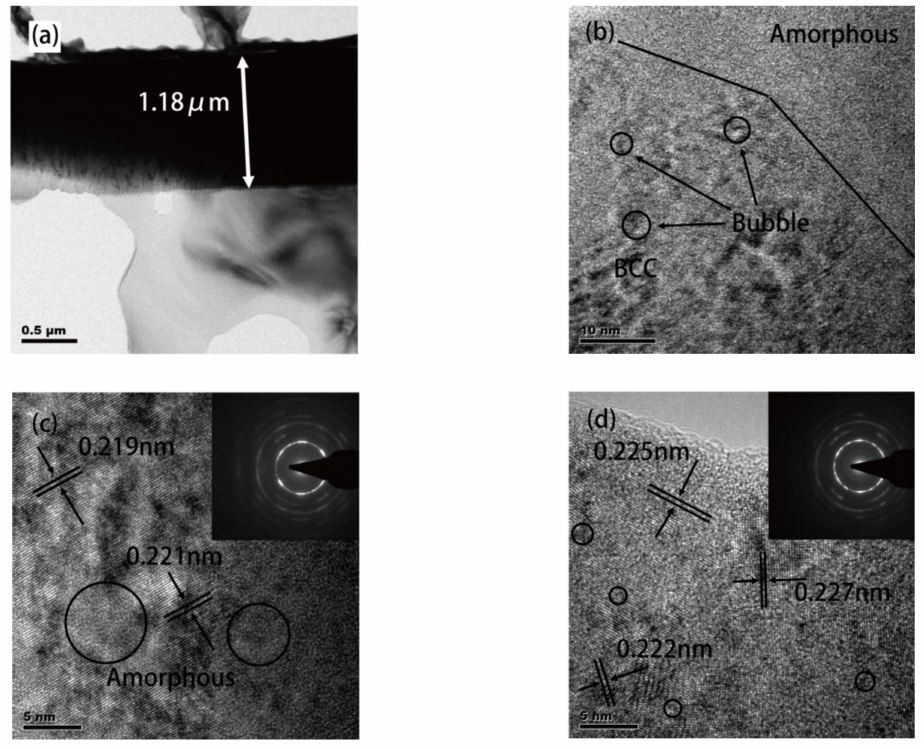
Figure 5. HRTEM and SAED images of Sample K (Ta10W10Ti24V26Cr29): ( a ) cross-sectional view of the film; ( b ) at the peak depth of damage after irradiation, the interface between the BCC phase and the amorphous phase; ( c ) before irradiation; and ( d ) the BCC polycrystalline structure after